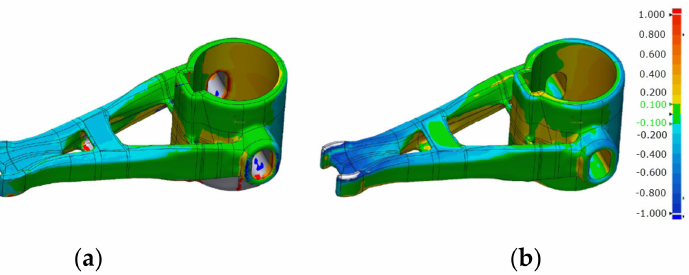
Figure 13. Representation of deviations detected by the 3D scanner: after printing ( a ) and after support removal ( b ).